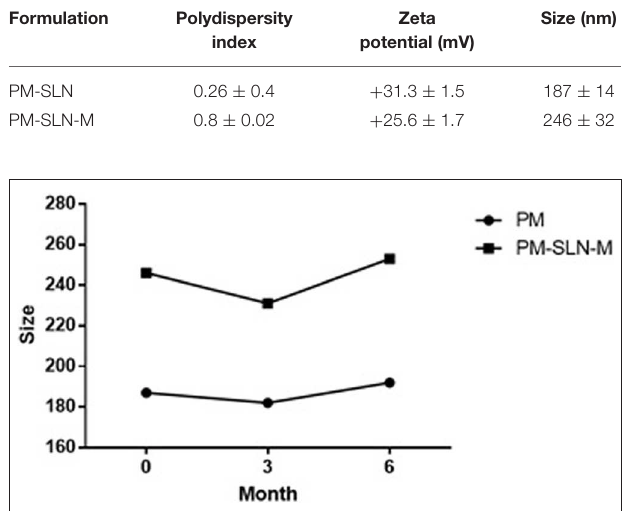
FIGURE 2 | The sustainability results of PM-SLN-M during 6-month